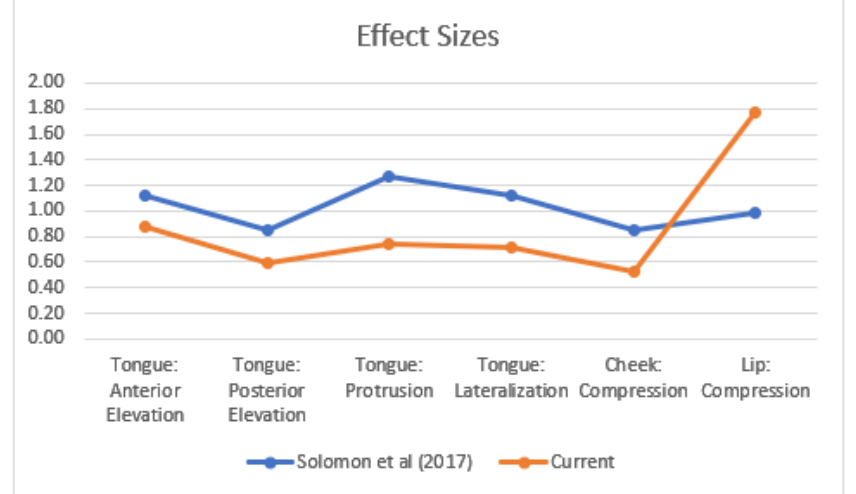
Figure 4. Effect sizes for the individual orofacial strength tasks for PWD from Solomon et al. [22] and the current study.